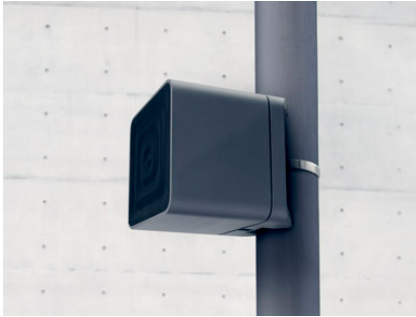
Figure 6. Prototype of the backhaul link installed on a lamp post.